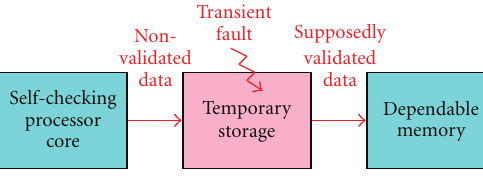
Figure 3: Data corruption in temporary storage.